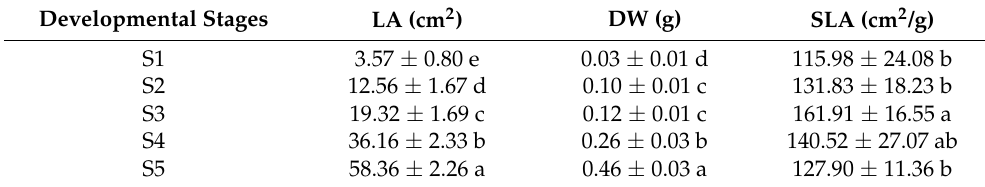
Table 1. Leaf area, leaf dry weight, and specific leaf area at different stages of Canephora coffee leaves. Developmental